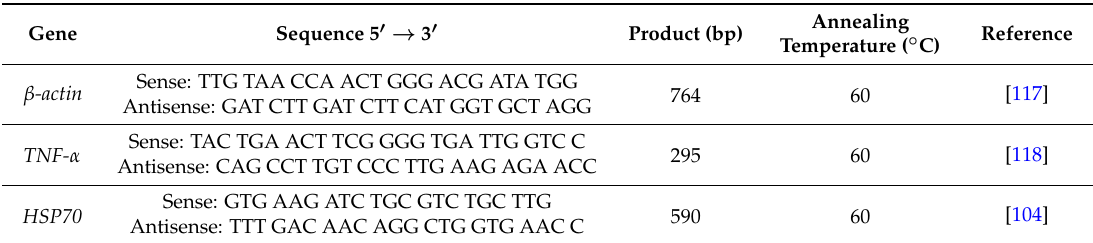
Table 2. Gene, primers’ sequences, product length, annealing temperatures,